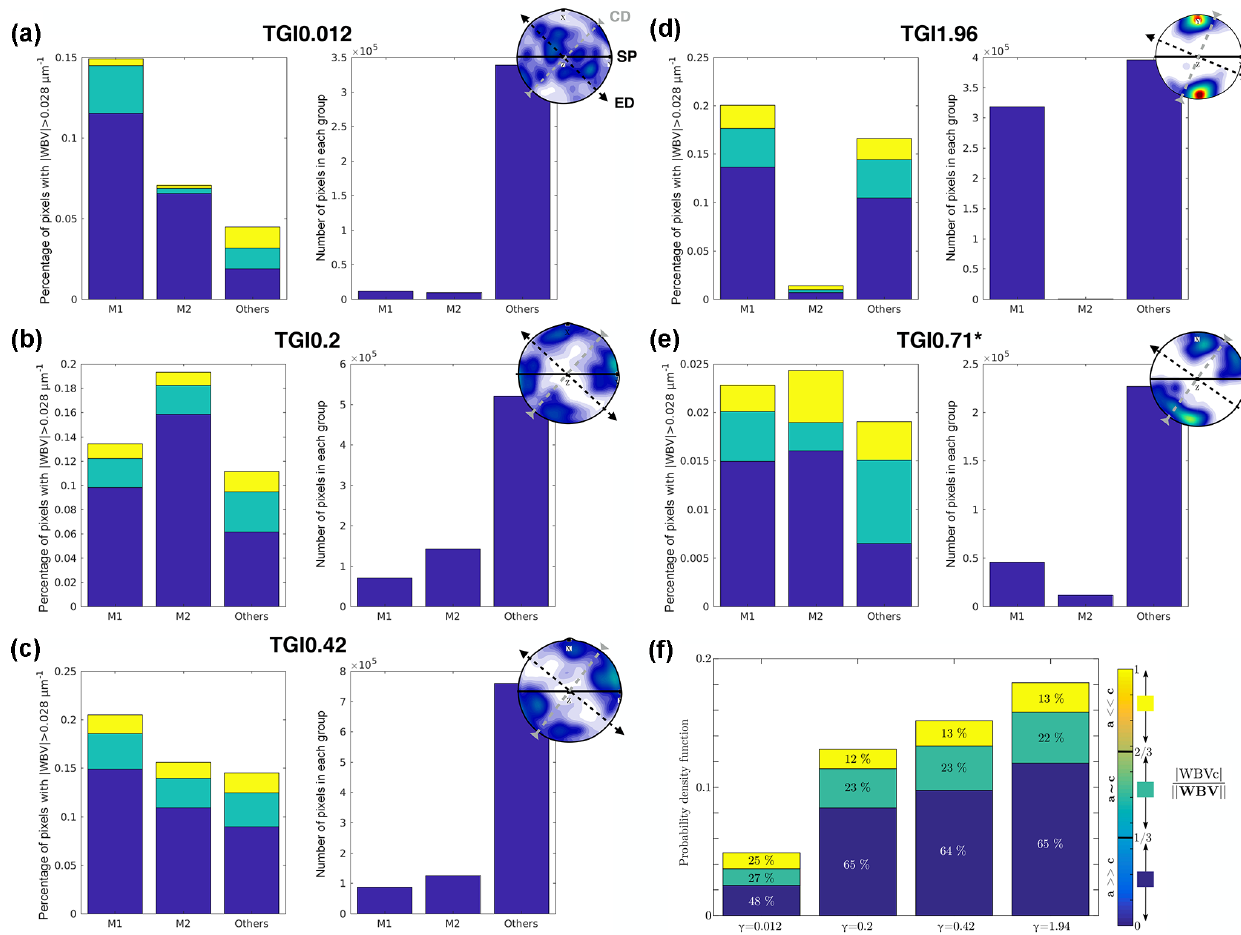
Figure 6. (a, b, c, d, e) Statistical distribution of pixels per group of orientation (M1, M2 sub-maxima or other) and per rWBV c ensemble for each γ max 0.012, 0.2, 0.42, 1.96 and 0.71, respectively, with the associated number of pixels per group. The c axis pole figure is also reported for each finite shear strain at the top right in each panel. (f) Distribution of pixels with a || WBV || higher than a threshold of (2 . 8 × 10 − 4 µm − 1 ). Evolution with torsion strain of the relative [ c ] and < a > components over the norm of the full WBV ( | WBV c | / || WBV || ) for four distinct torsion creep tests. See Chauve et al. (2017b) for more